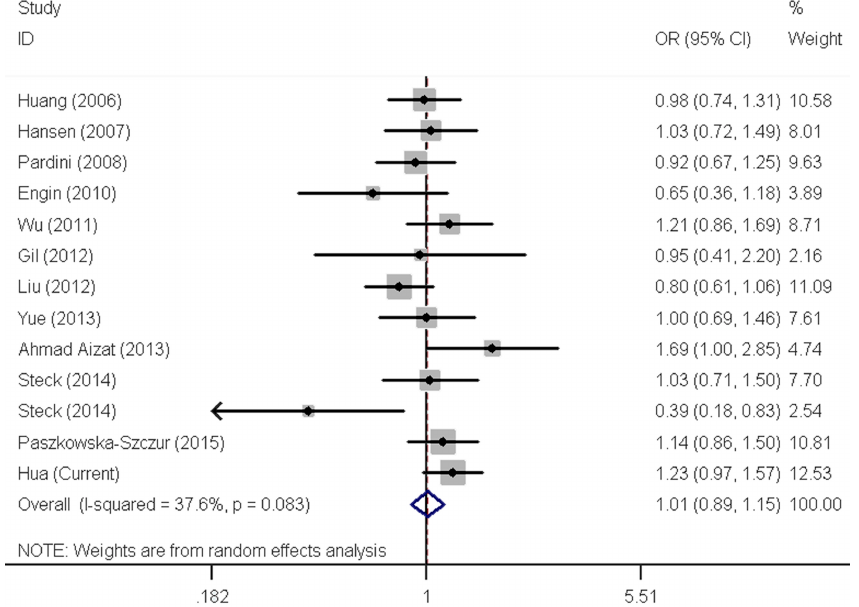
Figure 1. Forest plot of effect estimates for xeroderma pigmentosum group C ( XPC ) rs2228001 A > C polymorphism with overall colorectal cancer risk by a recessive model. For each study, the estimates of odds ratio (OR) and its 95% confidence interval (CI) are plotted with a box and a horizontal line. ♦ , pooled ORs and its 95% CIs. Genes 2016 , 7 , 73